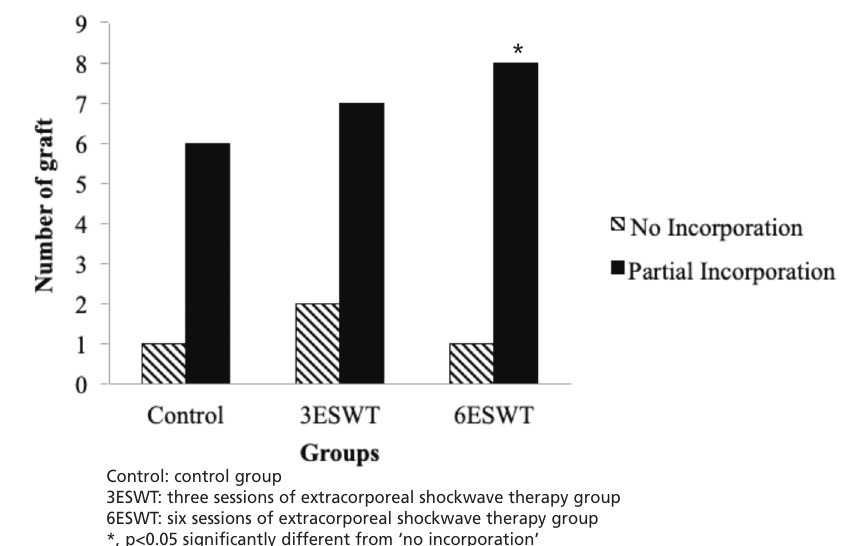
Frequencies of graft incorporation in the tibial tunnel in control, 3ESWT and 6ESWT groups at six months post-operatively. Fig. 1: